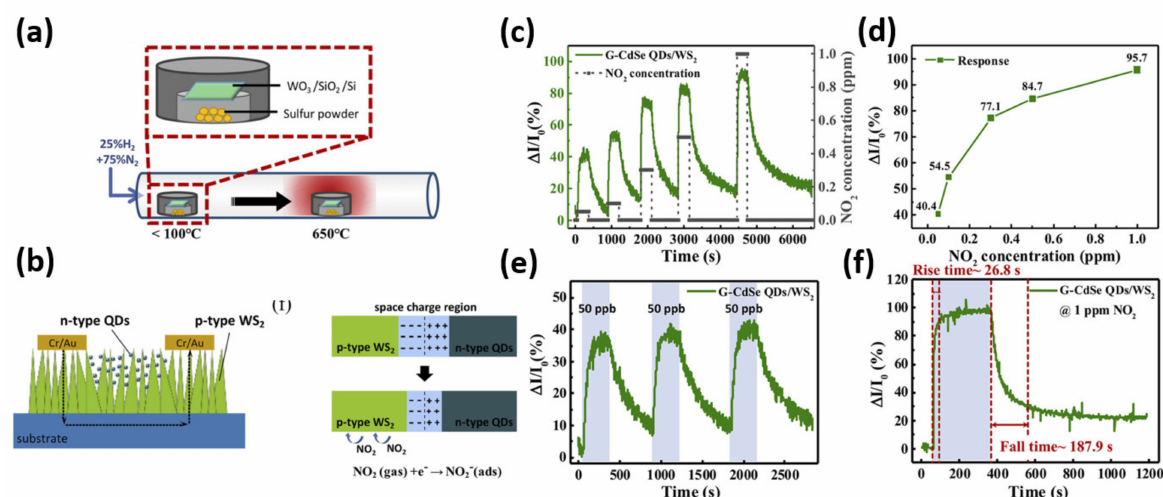
Figure 10. ( a ) Schematic of the synthesis process of WS 2 nanowalls by the horizontal furnace. ( b ) Structural model and p–n junction model of the QDs/WS 2 device before and after exposure to NO 2 gas. ( c ) Time-resolved response measurement of NO 2 . ( d ) Response of the G-CdSe QDs-WS 2 gas sensor as the function of NO 2 concentrations. ( e ) Stability test of the NO 2 -gas-sensing properties. ( f ) Rise time and fall time fitting of the G-CdSe QDs-WS 2 gas sensor. [57] Figure reproduced with permission from ACS